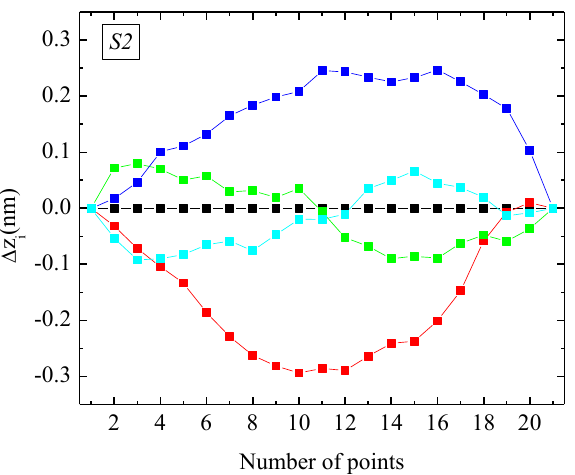
Figure 15. The out of plane motion of the cross line defined on the graphene sheet for all the atoms of the line at four different time spots (colored symbols), together with the initial snapshot (black symbols, t = 0) for the S2 system.